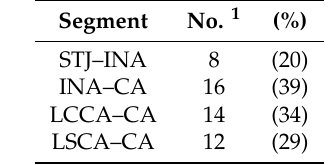
Table 4. Percentage of patients showing elongation in aortic segment at the fifth year.